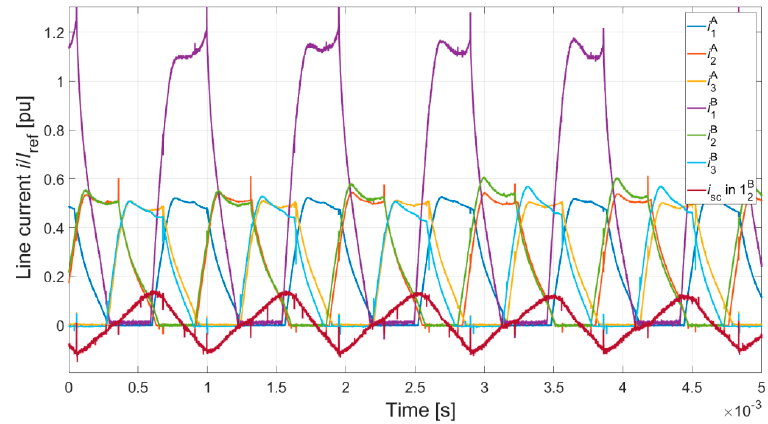
Figure 11. Relative electromagnetic torque and line currents in DCO mode for the DCBLDCM and the DCSRM at a shorted coil in channel B. (a) Electromagnetic torque for the DCBLDCM . (b) Line currents for the DCBLDCM. (c ) Electromagnetic torque for the DCSRM. (d) Line currents for the DCSRM.